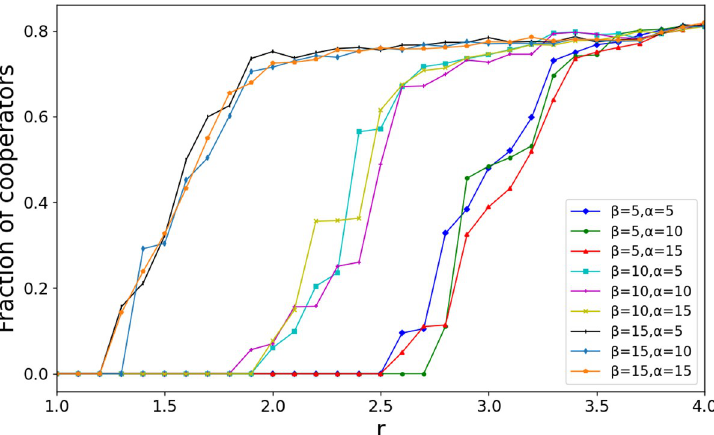
Fig 9. The fraction of cooperators as a function of the synergy factor r for different combinations of α and β with Model-I partner switching. The increase of β obviously promotes the emergence of cooperation. The change of α has little influence on the cooperation result. Parameters: N = 10000, t = 10000, T = 20, ^ k ¼ 4 , and ω = 0.1. https://doi.org/10.1371/journal.pone.0253527.g009 increase of β for different r did not always promote cooperation. When r is large ( r > 4), the increase of β will decrease the proportion of cooperators in the whole network. According to Fig 4(A), when r > 4 is observed, the collaborator can gradually dominate the whole network without the promotion mechanism. In Fig 10, the decrease of global cooperation proportion with the increase of β appears at r = 4, which is close to the threshold of static network coopera- tion emergence in Fig 4(A). Therefore, the increase of β can preserve partnerships when r is low, but it is not conducive to the global diffusion of cooperative strategy when the synergy